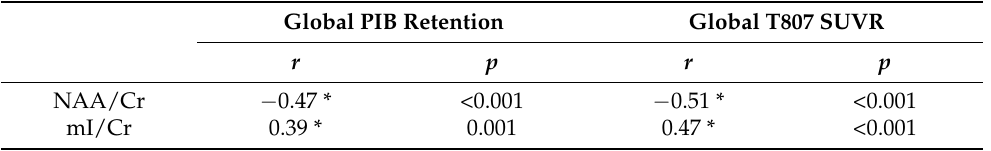
Table 2. Association between MRS metabolite ratios and PIB retention and T807 SUVR in the whole sample of participants.